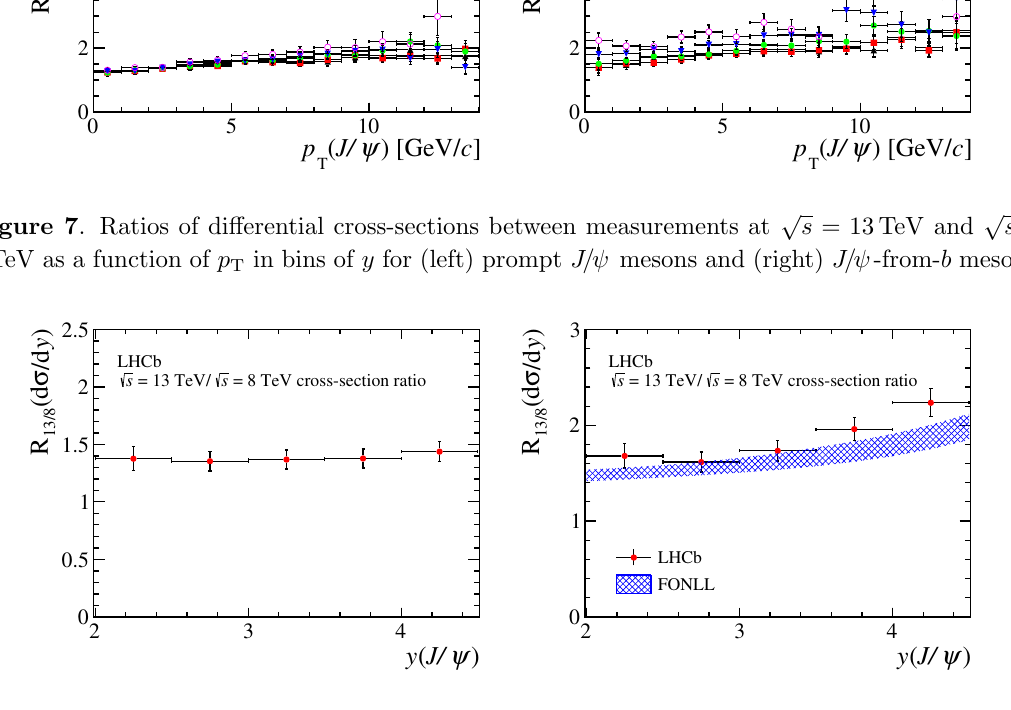
Figure 8 . Ratios of di(cid:11)erential cross-sections between measurements at 8 TeV as a function of y integrated over p T for (left) prompt J= and (right) J= -from- b mesons. The FONLL calculation is compared to the measured J= -from- b production ratio.